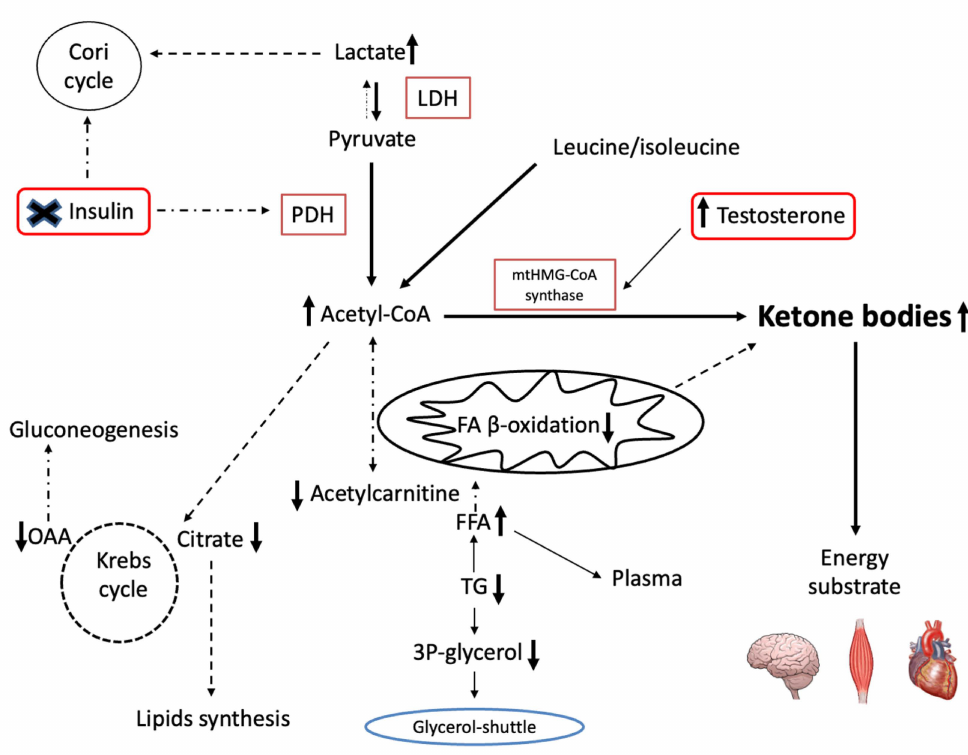
Figure 7. Summary of testosterone therapy effect on most metabolism pathways. In the dashed line the reduced metabolisms are shown, while in the not dashed line, the positively influenced metabolisms are shown. Arrows indicate increases or